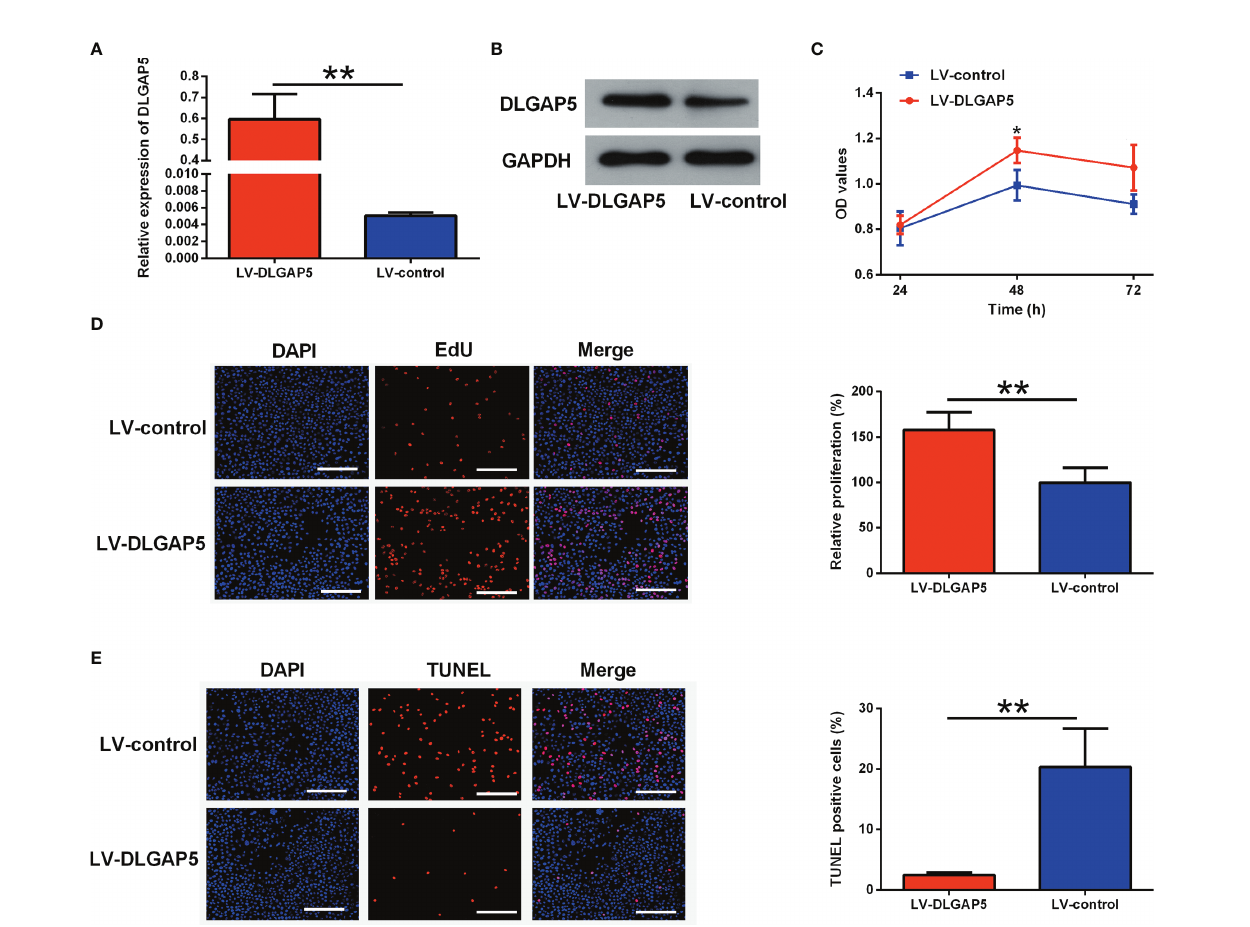
FIGURE 9 | Effects of DLGAP5 overexpression on the granulosa cell proliferation and apoptosis. Granulosa cells were transfected with LV-control or LV-DLGAP5, and after transfection, (A) the mRNA expression level of DLGAP5 in the granulosa cells was determined by qRT-PCR; (B) the protein expression level of DLGAP5 in the granulosa cells was determined by western blot; (C) the cell viability of granulosa cells was determined by CCK-8 assay; (D) the cell proliferation of granulosa cells was determined by EdU assay, scale bar = 100 µm; (E) the cell apoptosis of granulosa cells was determined by TUNEL assay, scale bar = 100 µm. *P < 0.05 and **P <